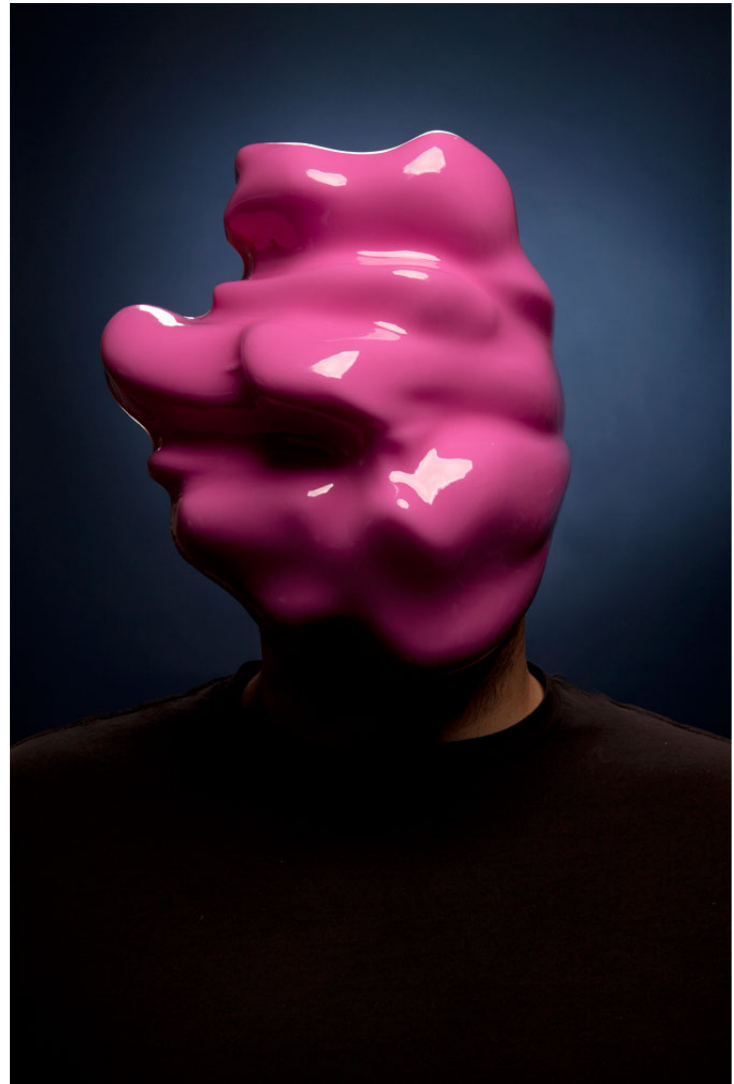
Zach Blas , Facial Weaponization Suite: Fag Face Mask – October 20, 2012, Los Angeles, CA